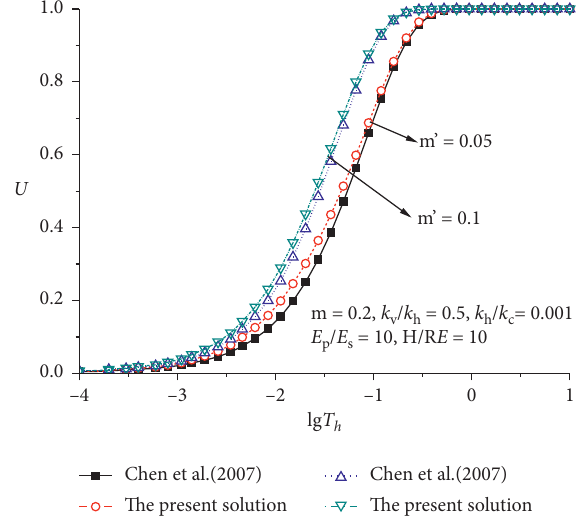
Figure 7: Comparative analysis of consolidation rate of combined composite